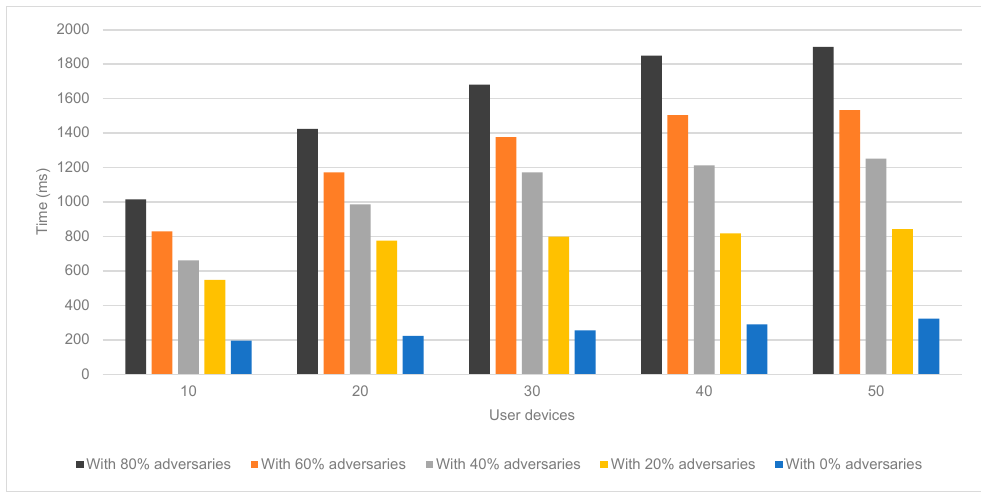
Figure 6. Finalization latency evaluation. To simulate the massive interaction behaviors and DHCPREQUEST and